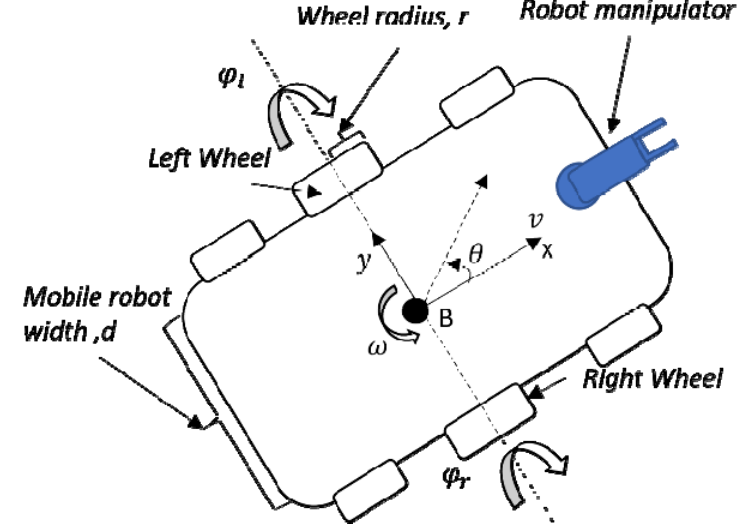
Figure 5. Energy management simulation blocks